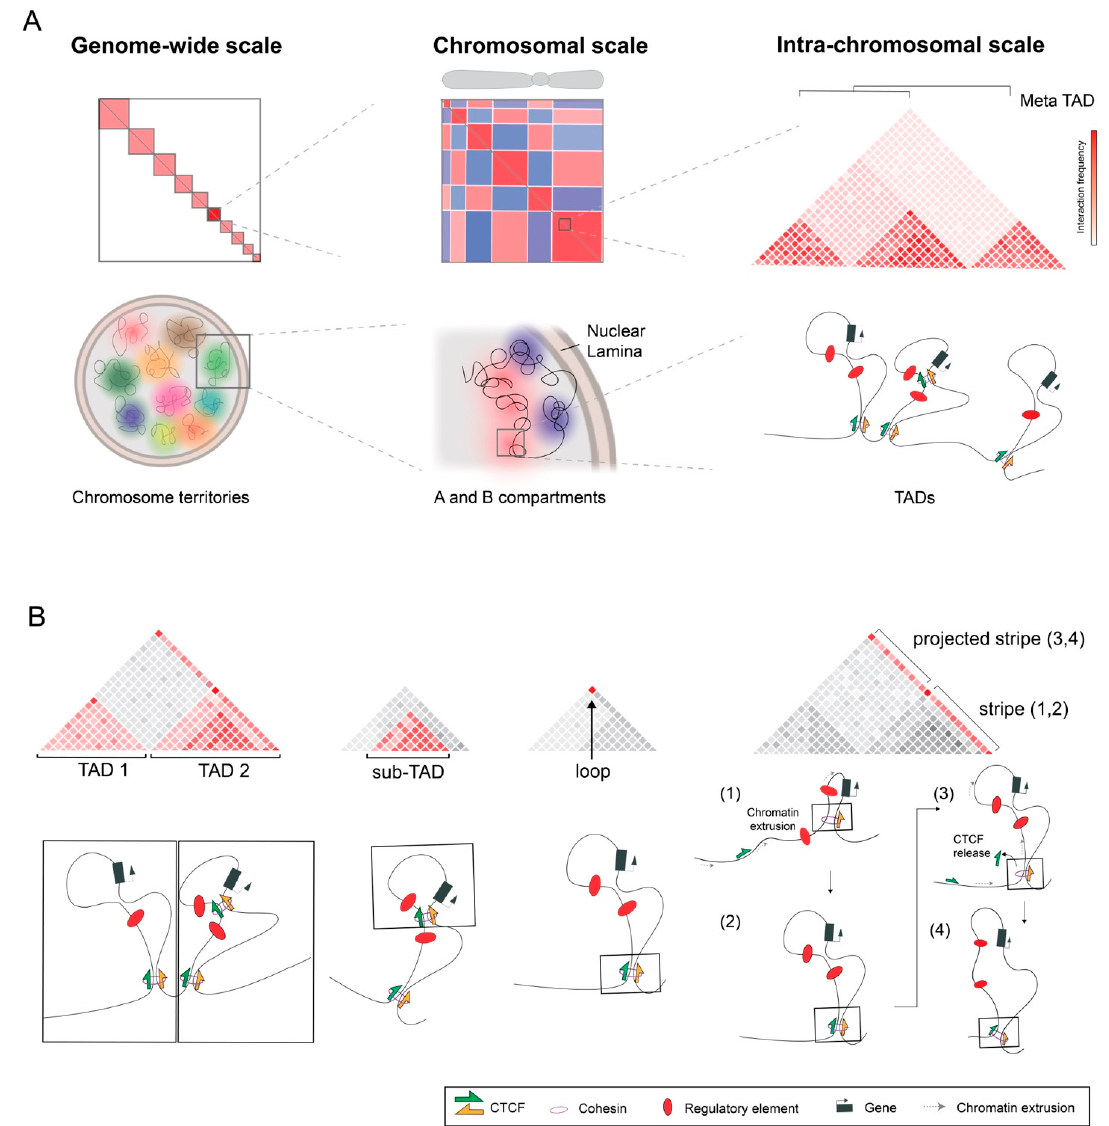
Figure 1. Prominent features observed in Hi-C maps. ( A ) At a genome wide level, chromosomes